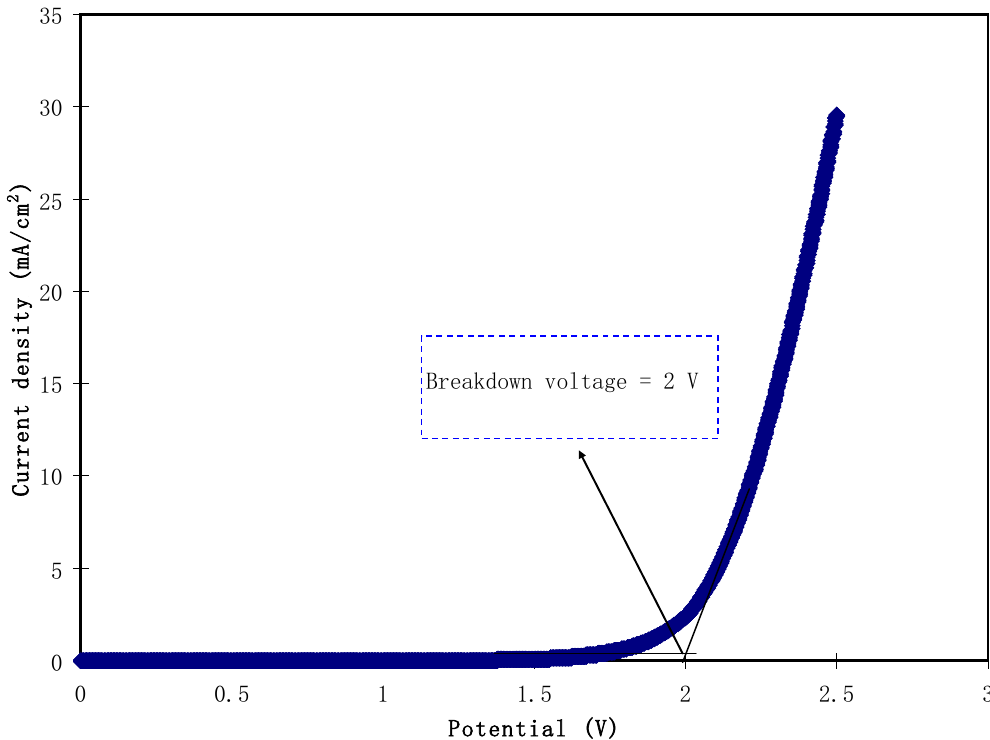
Figure 5. Linear sweep voltammogram for the PVCH3 electrolyte sample at room temperature.